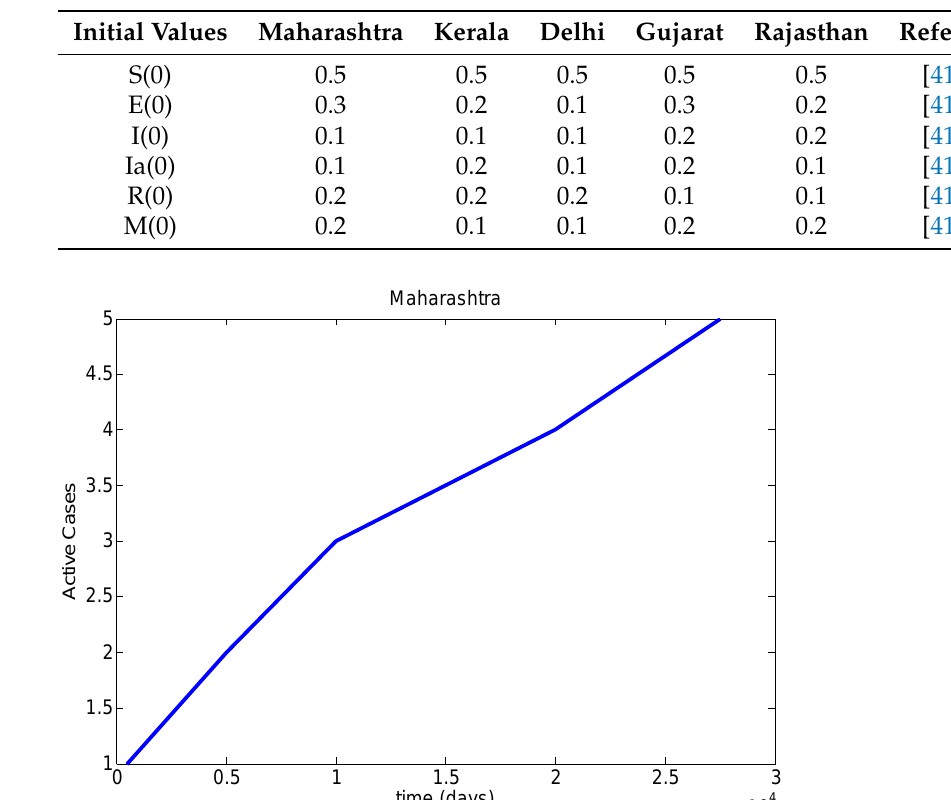
Figure 7. Active cases of Maharshtra from real life